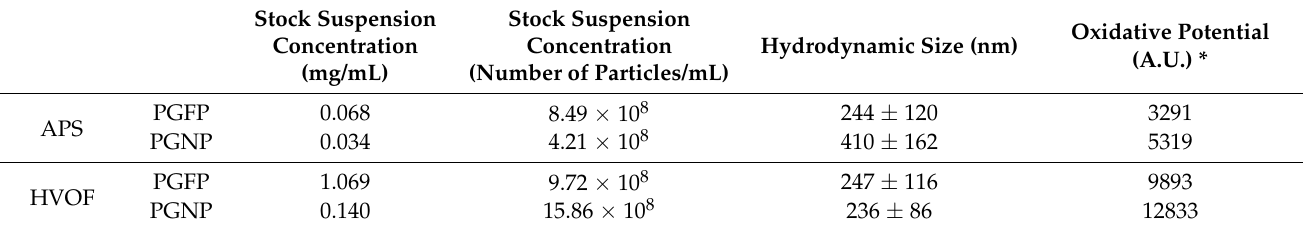
Table 1. Physicochemical characteristics of the tested PGFP and PGNP aqueous